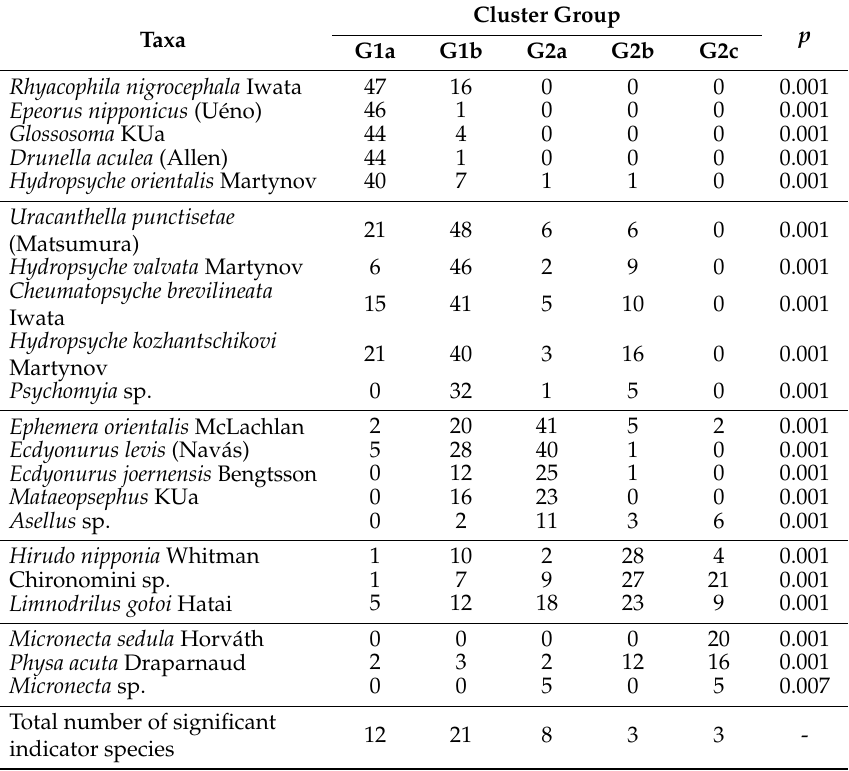
Table 3. Indicator values (%) for the most important species ( p < 0.05) in each cluster group. Monte Carlo tests (999 permutations) were used to assess the significance of each species as an indicator for the respective group (G1a–G2c). In total 50 species whose contribution to total density was higher than 0.2% were analyzed. Less important species were not shown in this